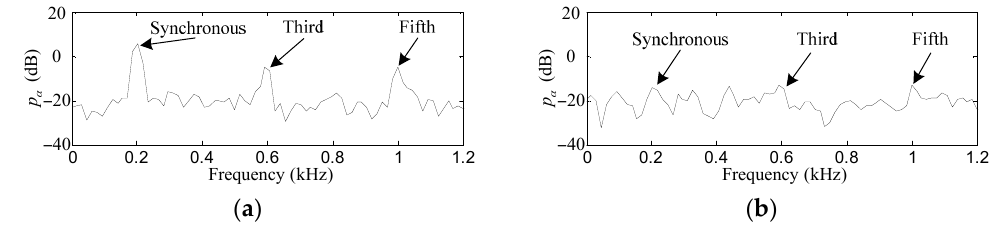
Figure 9. Simulation results of p α . ( a ) before harmonic torque elimination; ( b ) after harmonic torque elimination.